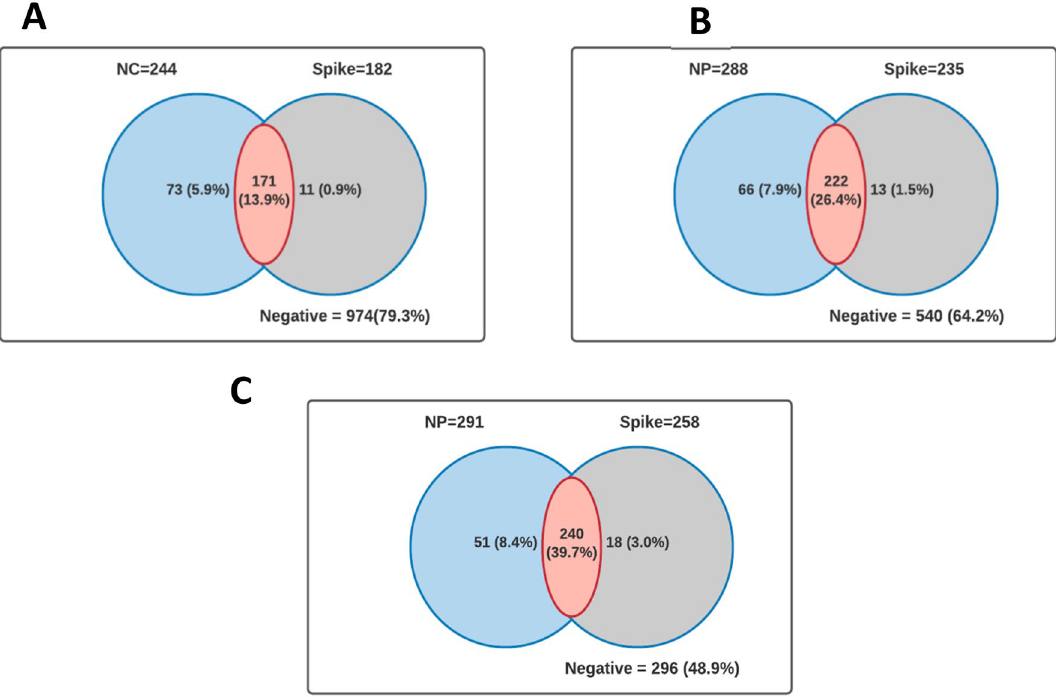
Figure 1. Venn diagram showing the distribution of seroprevalence by antigenic protein ( A ) survey 1, ( B ) survey 2, ( C ) survey